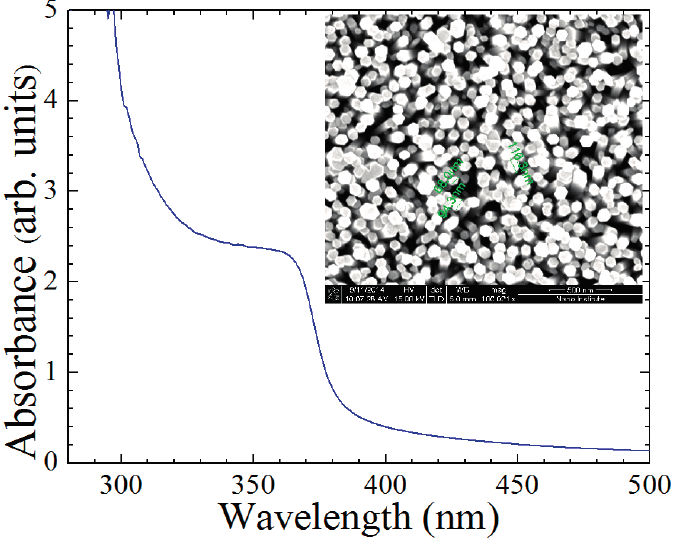
Figure 2. Absorbance spectrum of ZnO nanorods and its optical peak is around 370 nm corresponding with the band gap of the material and the inset figure refers to the hexagonal structure of the ZnO nanorods that was taken by SEM image with a variety in diameter from 68 to 116.3